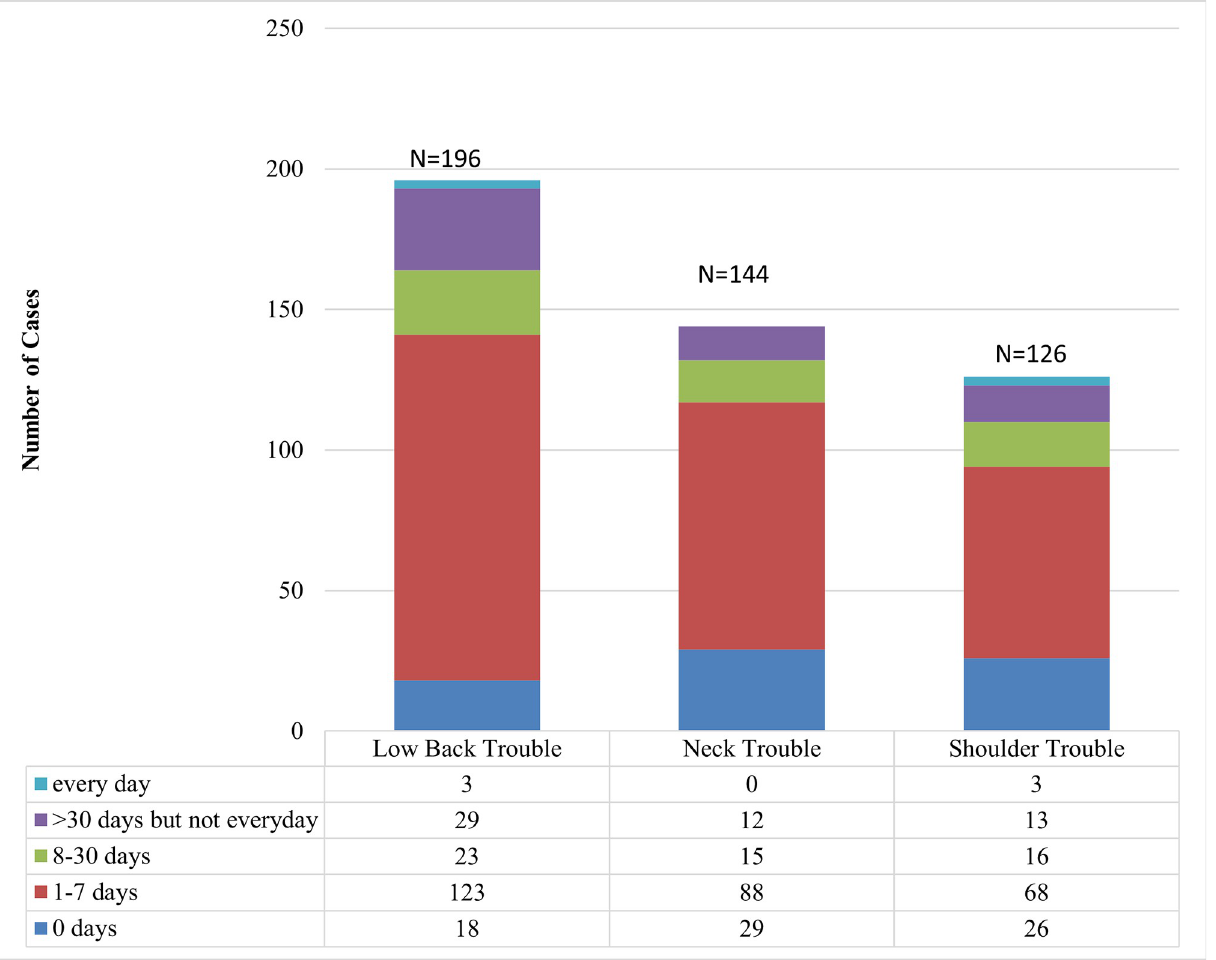
Fig 2. Number of days’ study participants experiencing musculoskeletal